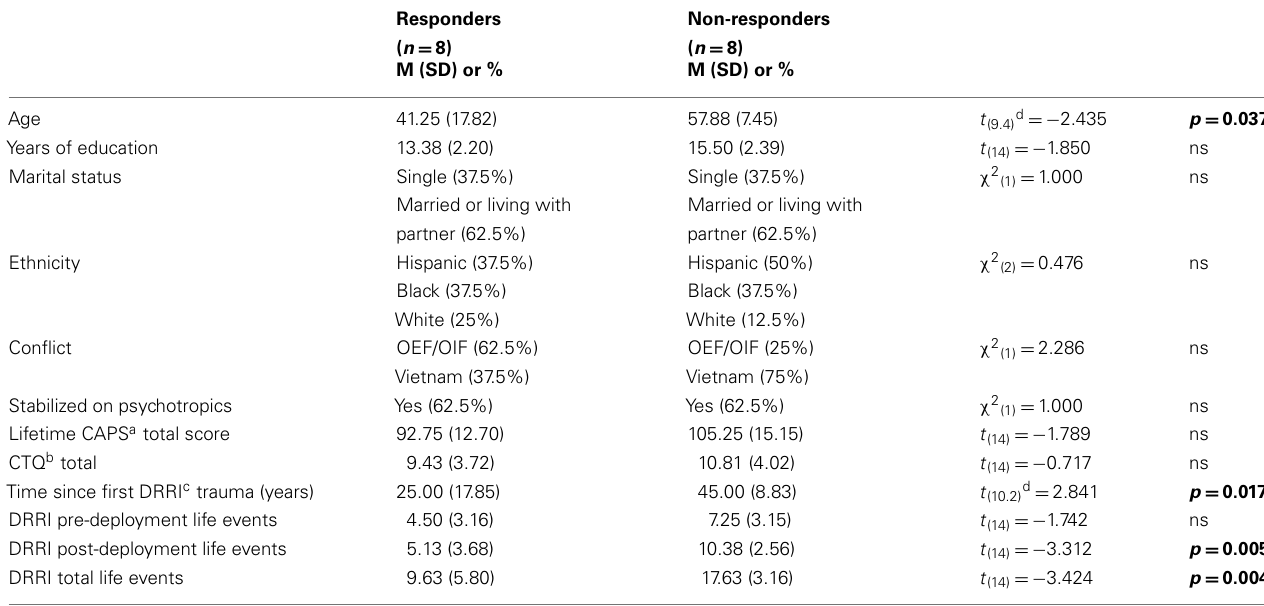
Table 1 | Baseline characteristics comparing responders to non-responders.